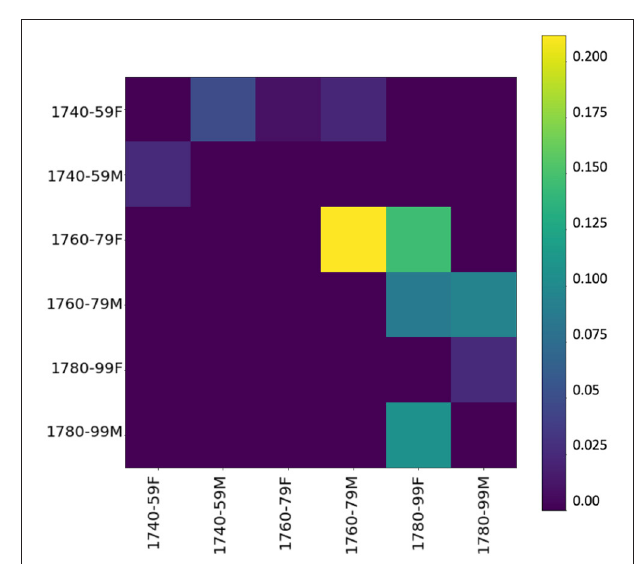
FIGURE 9 | Influencer heatmap of event cascades over time at the grammatical level